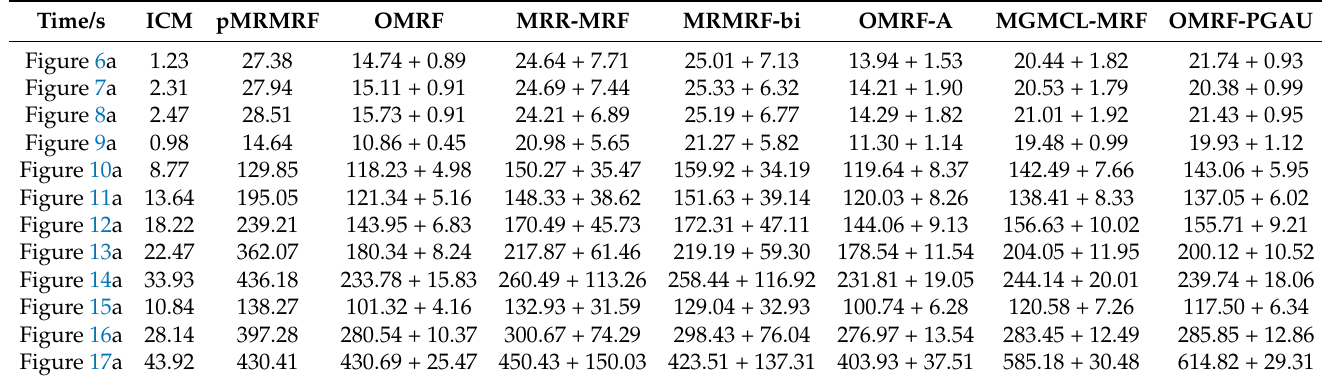
Table 5. The computational time of eight methods for the experimental